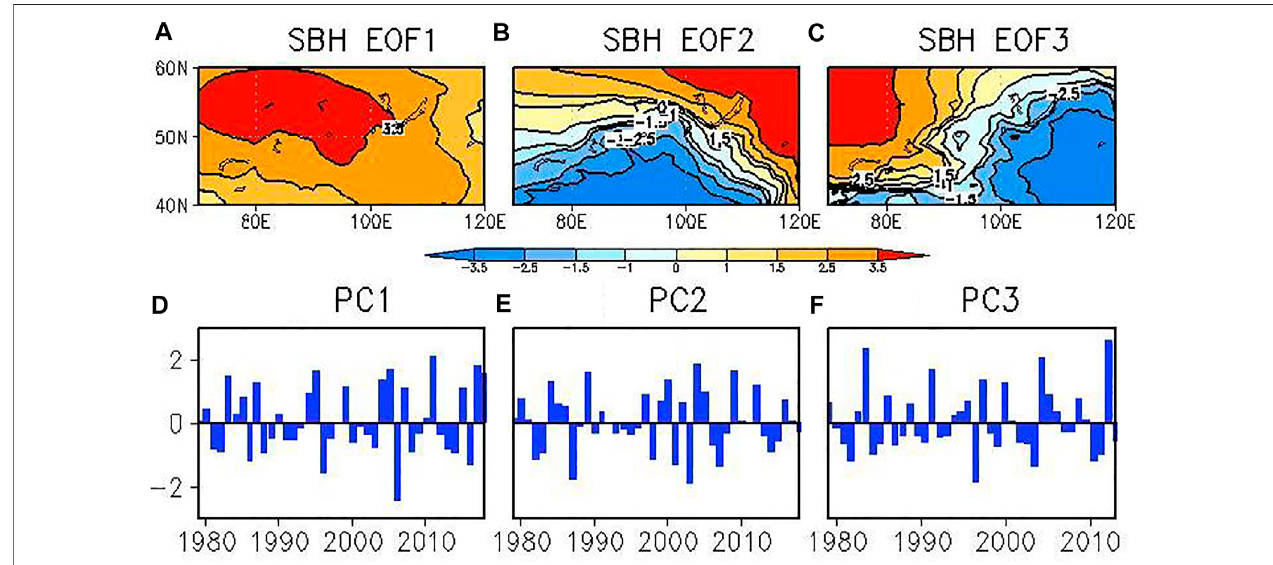
FIGURE1| Spatialpatternsandcorrespondingprincipalcomponentsofthe fi rst (A,D) ,second (B,E) ,andthird (C,F) EOFmodeofwinter-meanSLPintheSiberian high domain (40 – 60 o N, 70 – 120 o E) in 1979 – 2019 for ERA5 Reanalysis.